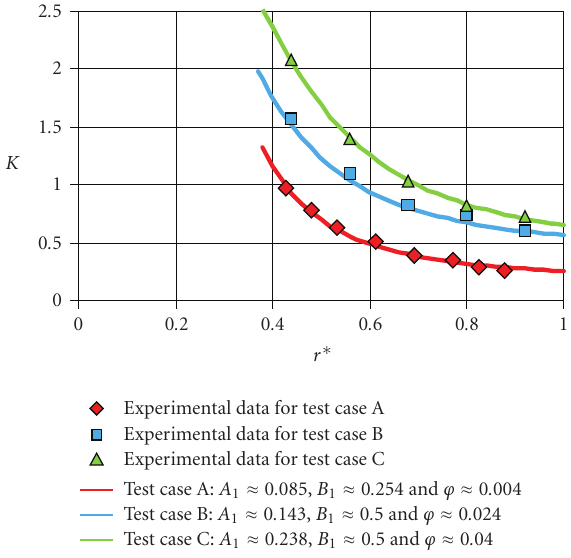
IRPHE experimental data without post swirl IRPHE experimental data with post swirl IRPHE model Relation (20): a 1 ≈ 8 . 85 and B 1 ≈ 0 . 5 and ϕ ≈ 1 . 45 Figure 16: Core swirl ratio distribution deduced from (20). Comparison with experimental and numerical results from Poncet